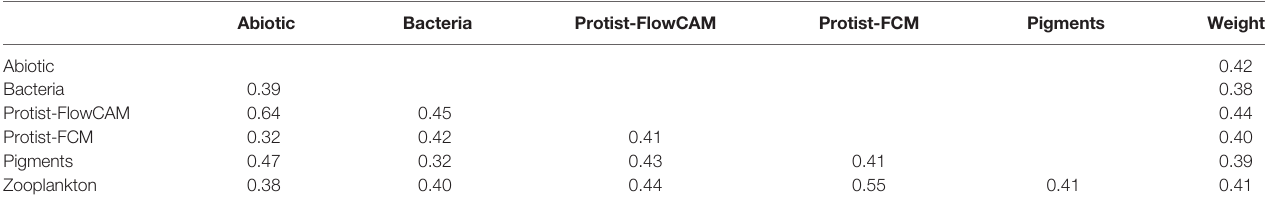
TABLE 4 | RV correlations between ecosystem components.